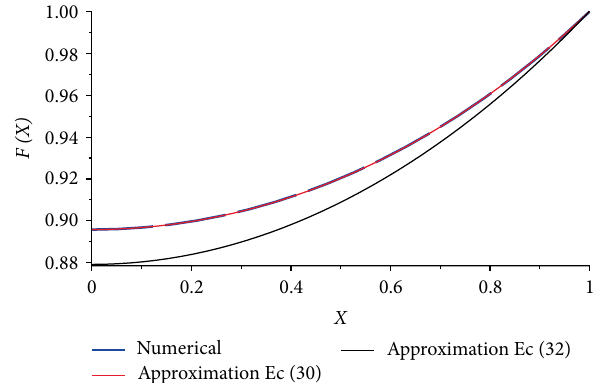
Figure 2: Comparison between numerical solution of (13) and approximations (30) and (32) for 휀 =